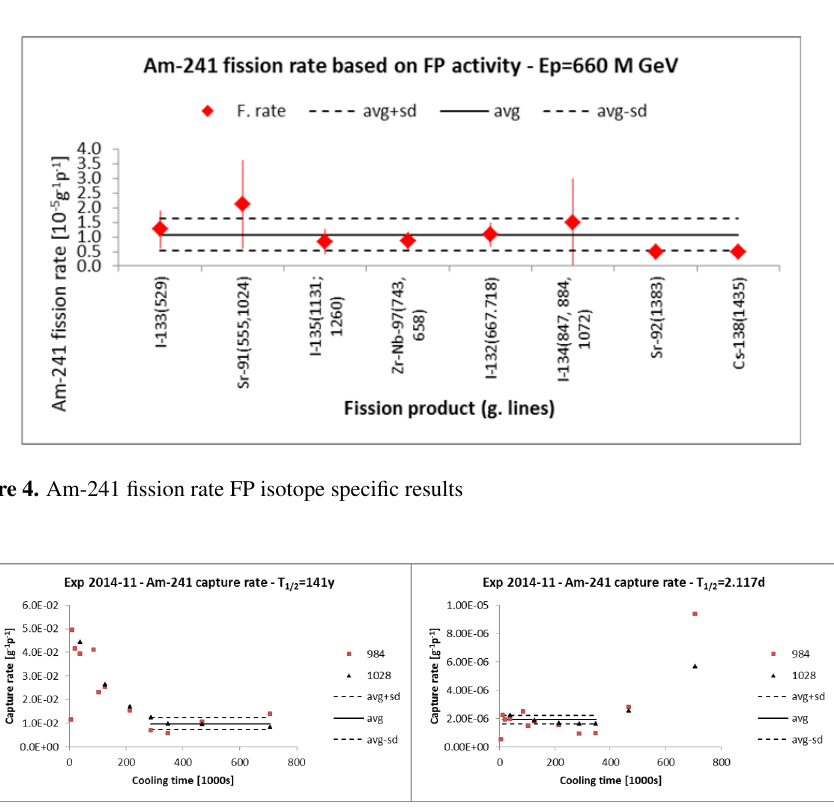
Figure 5. Line 984 and 1028 keV corrected activity showing that there are two independent sources of the specified